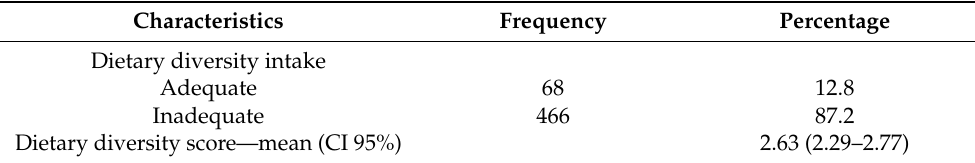
Table A2. The association between mother’s education, household and adequate dietary diversity